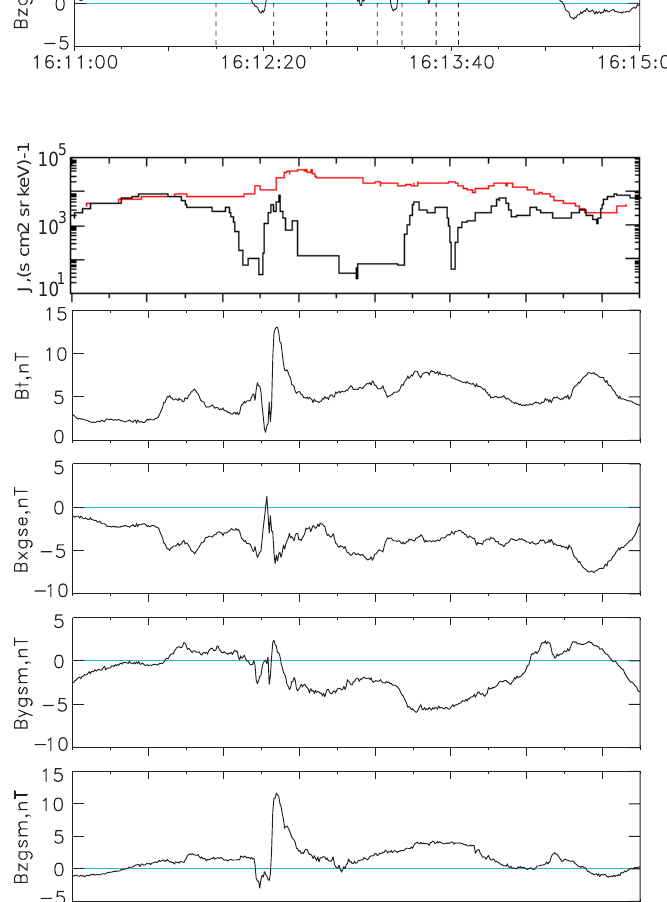
Fig. 3a. Sequence of 7 structures in the magnetic field and electron fluxes be- tween 16:11 and 16:15UT. From top to bottom: the electron energy-time spec- trogram, and B , B X , B Y , B Z in GSM coordinate system. Vertical dashed lines separate the observed structures.